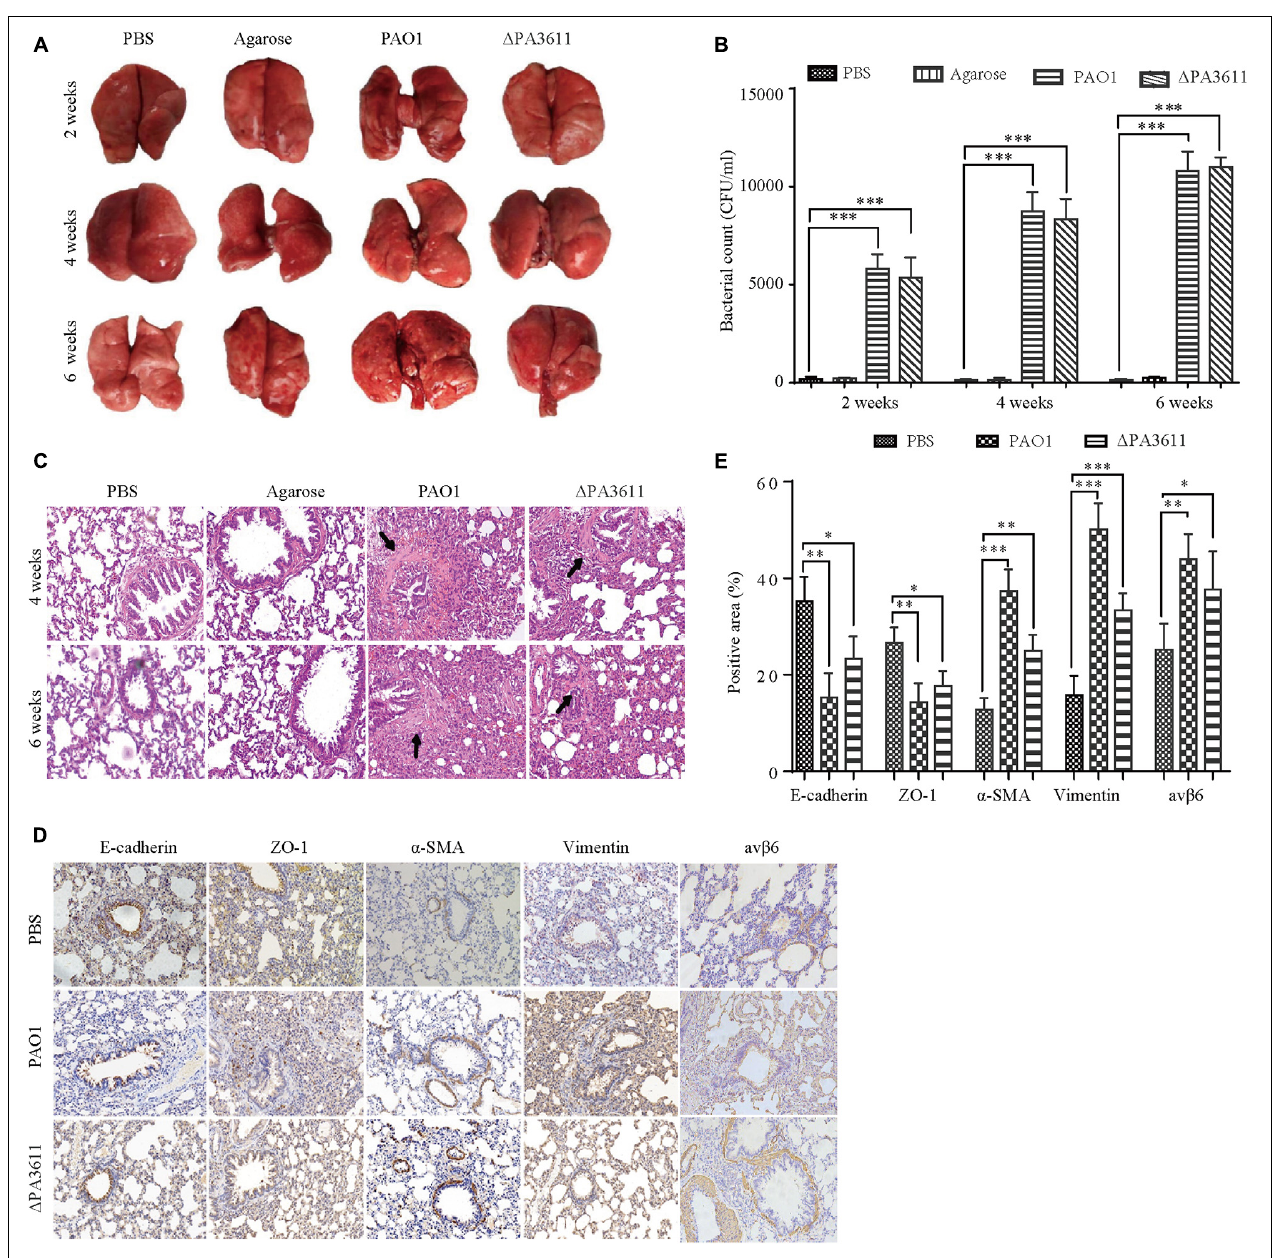
FIGURE 7 | Effects of PA3611 on lung infection and EMT in vivo . Six- to eight-week-old male Wistar rats were intratracheally infected with the PAO1 or (cid:49) PA3611 bacterial strain. The strains were coated with agarose and agarose, and PBS was used as a control. Lungs were collected at 2, 4, or 6 weeks post-infection. Overall gross views of lung tissues from the four groups at 2, 4, and 6 weeks post-infection are shown (A) . Bacterial load tests were performed in the above four groups at 2, 4, and 6 weeks post-infection (B) . HE staining (C) and immunohistochemical staining of E -cadherin, ZO-1, α -SMA, vimentin and integrin α v β 6 (D) were performed. The scale bar represents 100 µ m. Morphometric analysis of EMT-related protein-positive areas and integrin α v β 6 was performed on immunohistochemically stained sections of lung tissues (E) . The lung injury results are representative of three independent experiments. The data are presented as the mean ± SD, NS, no significance, ∗ P < 0.05, ∗∗ P < 0.01, ∗∗∗ P < 0.001, vs. the control